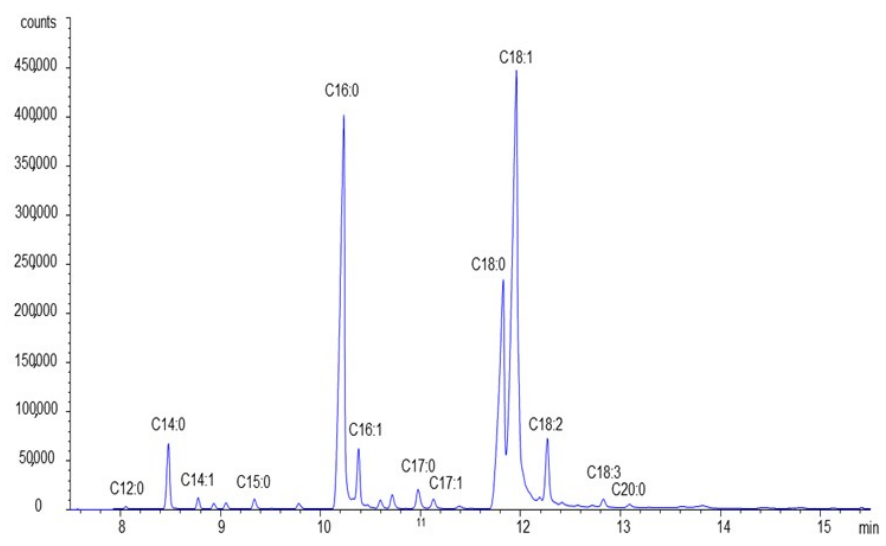
Figure 4. Chromatogram of examined fats (bovine fat).